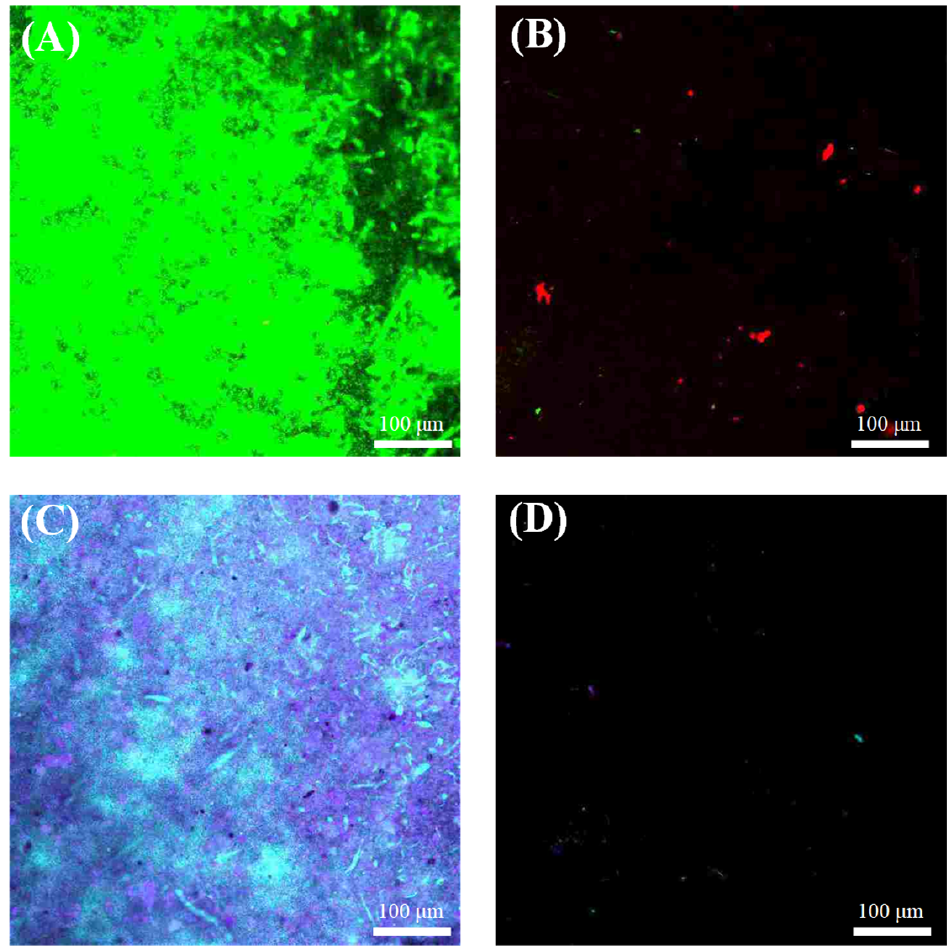
Figure 8. CLSM images exhibiting the biofilms on M0 (( A ) and ( C )) and MQ (( B ) and ( D )) at the end of filtration. “Live”, “dead” cells, α -polysaccharides and proteins in biofilms were labeled by SYTO 9 (green), PI (red), Con A (blue) and SYPRO Orange (yellow), respectively.